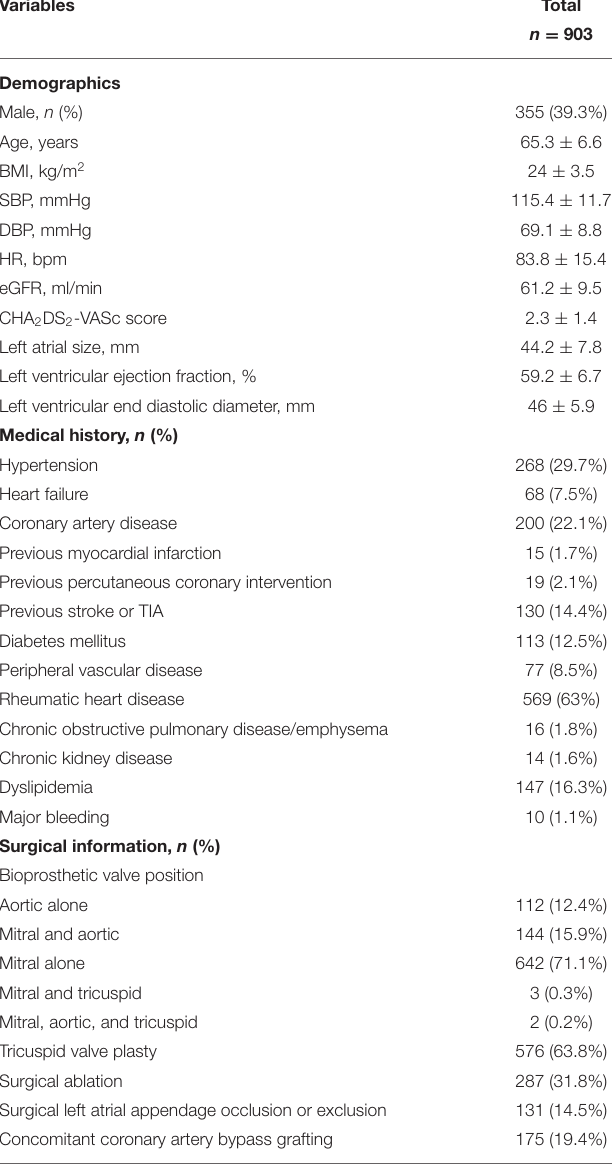
TABLE 1 | Baseline characteristics of